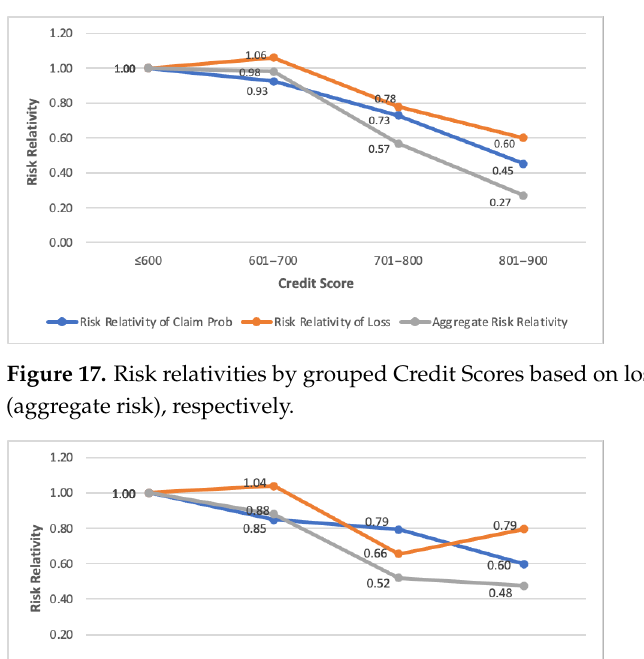
Figure 16. Risk relativities by grouped Annual Mileage Driven based on loss severity, frequency, and loss cost (aggregate risk), respectively.